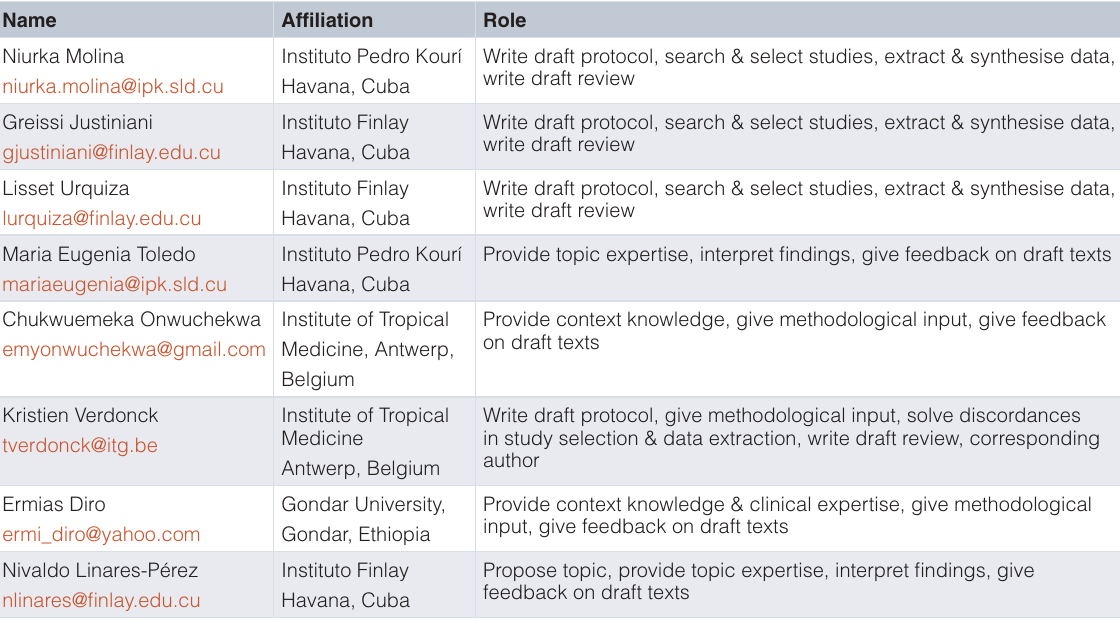
Figshare: SupplementaryInformation_Eligibility_DataExtraction. https://doi.org/10.6084/m9.figshare.10078928.v1 8 . Data are available under the terms of the Creative Commons Attribution 4.0 International license (CC-BY 4.0).